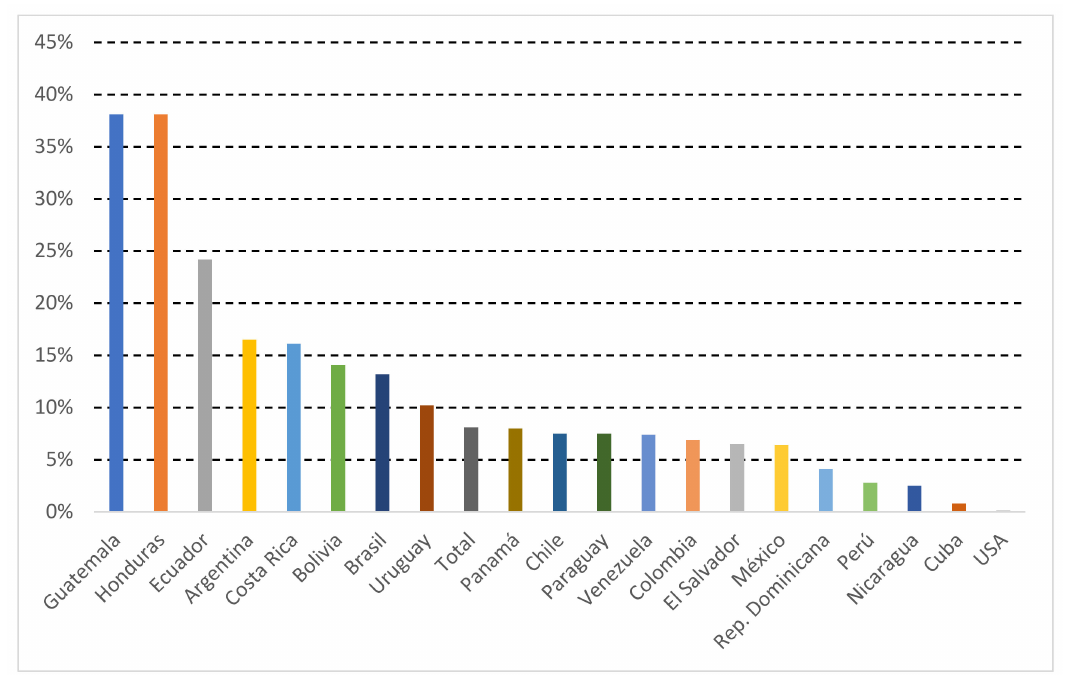
Figure 2. Participating members/Total Membership from each country (%). United States of America (USA). Republic (Rep).